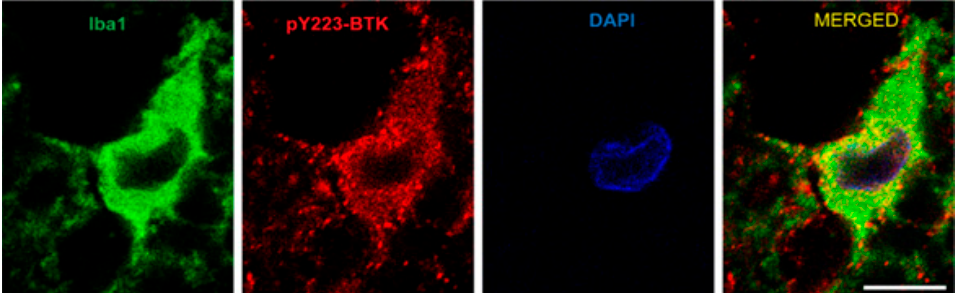
Figure 4. Phospho-BTK is localized to microglia 3 days following SCI, measured by immunofluo- rescence imaging. Photomicrographs of representative transverse spinal sections taken from spinal cord injured rat. Double immunofluorescent imaging analysis of spinal cord sections at lesion site showed phospho-BTK (red) expressed in microglia (Iba1, green) 3 days post-injury. The sections were immunostained with a primary antibody against phospho-BTK (red), and Iba1 (green) and counterstained with DAPI to identify cell nuclei. Phospho-BTK immunostaining was uniformly ob- served in cells immunoreactive for Iba1 (a specific calcium-binding protein for activation of micro- glia and macrophages [54]). This is from 3 days post SCI, at which time the Iba1 cells are predomi- nantly microglia. The SCI conditions are as described in other figures. The images were obtained from the ventral white matter, in a section rostral 1 mm from the lesion epicenter using the Nikon confocal microscopy system (Nikon C2+, Melville, NY, USA) in the Spinal Cord and Brain Injury Research Center imaging core at the University of Kentucky. Scale bar: 10 µm.